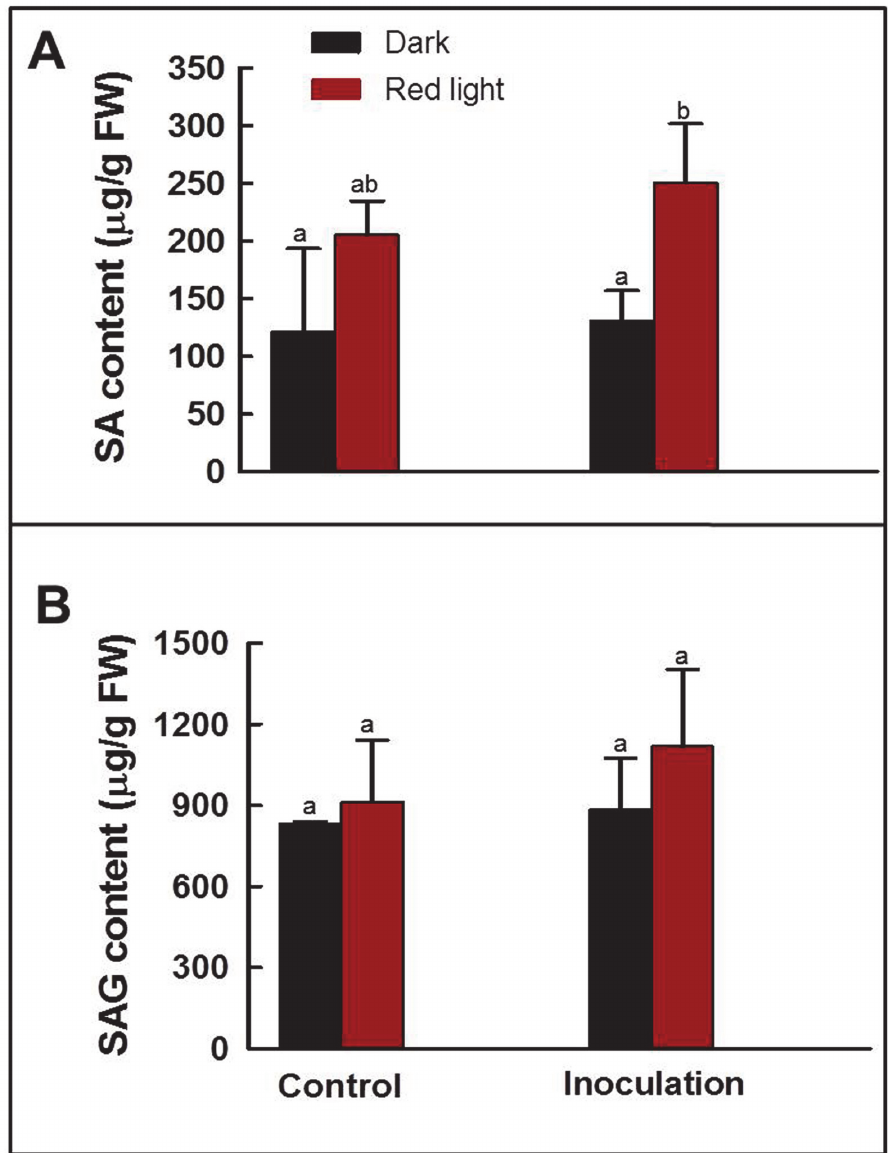
Fig 3. Content of free and conjugated salicylic acids. (A) Free salicylic acid (SA) and (B) glucose- conjugated salicylic acid (SA glucoside, SAG) in soybean sprouts grown in darkness or under red light irradiation. The SA and SAG contents of germinated soybean sprouts were measured without inoculation of Pseudomonas putida 229 (control), or after inoculation for 8 h followed by incubation in darkness for 24 h (inoculation). The experiments were repeated two times. The different letter indicates a significant difference ( P < 0.05).